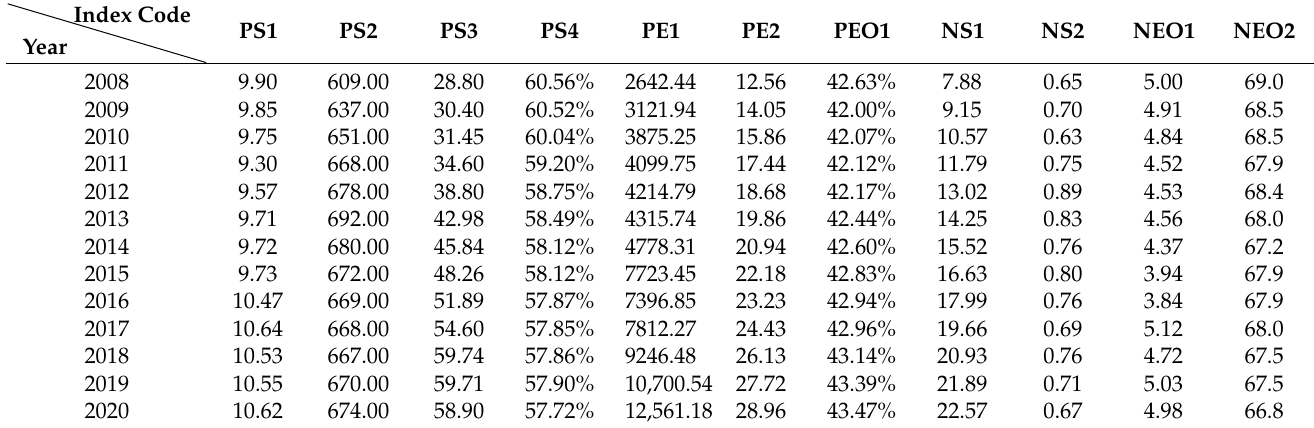
Table 2. Data of the externality indexes of highway infrastructures in Jiangsu from 2008 to 2020.